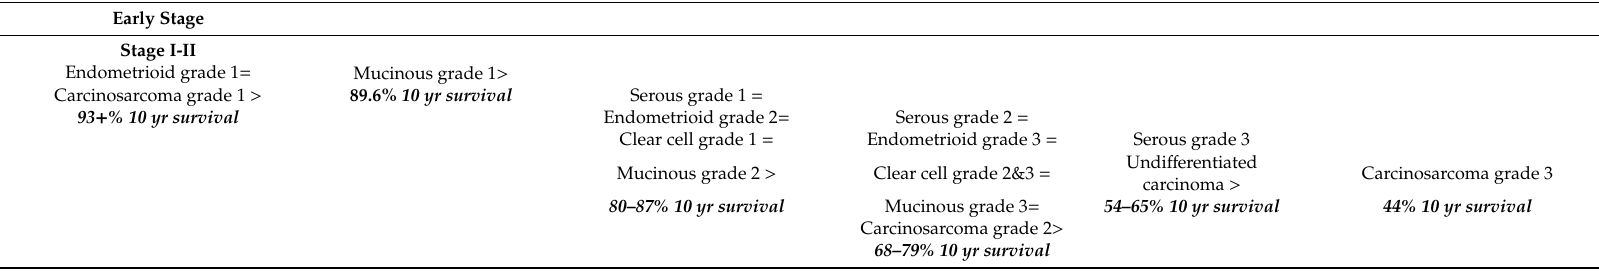
Table 2. DSS Groupings of Early Stage EOC Subtypes Based on Grade. Breakpoints in survival were determined by Log rank test for significant di ff erence of pairs of EOC subtype grades arranged successively. Breakpoints for statistically significant groupings: 93%, 90%, 80–87%, 68–79%, 54–65% and 44% 10-year DSS.